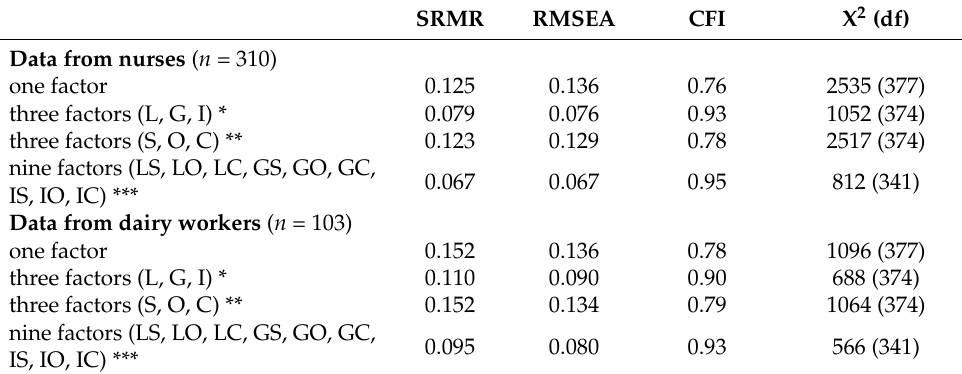
Table 2. Results from CFA analyses of model fit in the two datasets. SRMR RMSEA CFI X 2